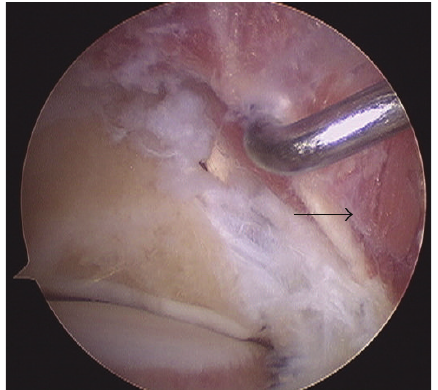
Figure 3: Accessory muscle belly (black arrow).